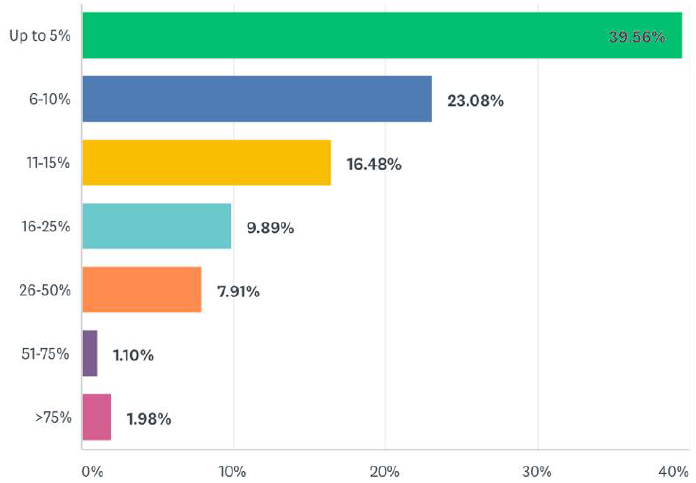
Figure 9. Amount U.S. participants are willing to pay—support locally sourced food/farming industry. Note: responses to the question “If you responded ‘Yes’ to the previous question, how much would you be willing to increase your restaurant bill/hotel food expenditure in order to support Hawai’i’s local farming industry?”.